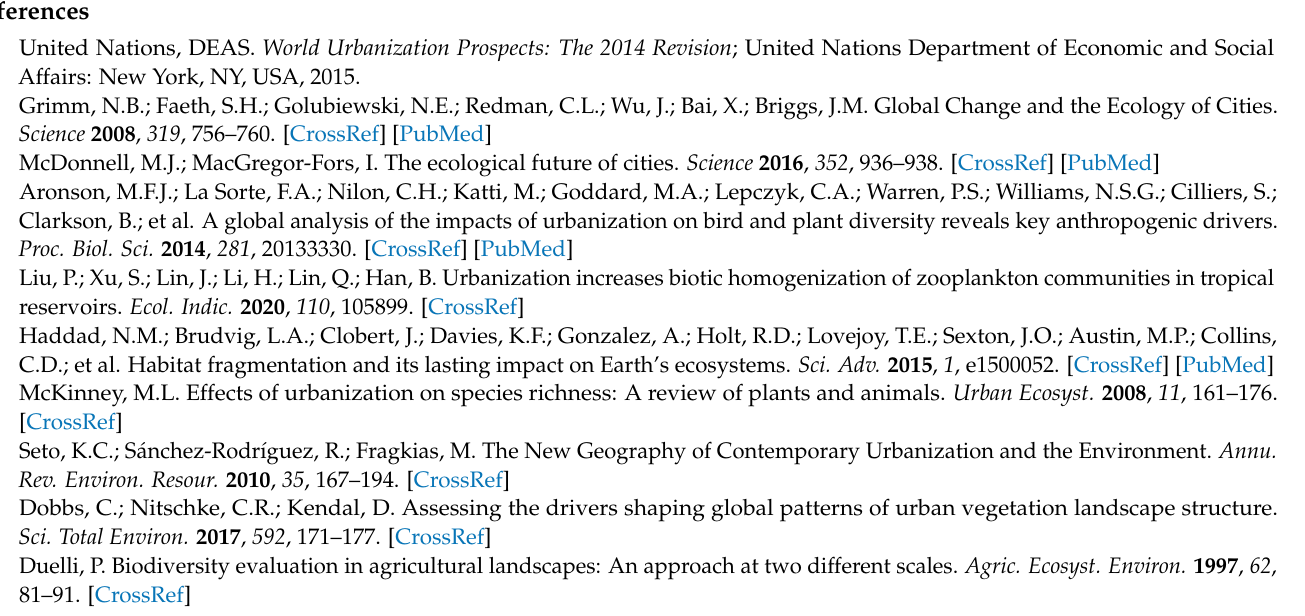
Correlation coefficient matrices for eight independent landscape variables at different spatial scales; Table S4: The best models ( ∆ i ≤ 2) examining relationships between multi-scale landscape variables and the relative abundances of five anuran species, total anuran relative abundance, and anuran species richness in 44 urban ponds in Shanghai. The best models predicting P. nigromaculatus are shown in Table S4a; the best models predicting F. multistriata are shown in Table S4b; the best models predicting M. fissipes are shown in Table S4c; the best models predicting B. gargarizans are shown in Table S4d; the best models predicting P. plancyi are shown in Table S4e; the best models predicting total anuran abundance are shown in Table S4f; the best models predicting anuran species richness are shown in Table S4g; Table S5: Model-averaged coefficients and 95% confidence intervals showing the direction relative magnitude of the effects of landscape variables on anuran relative abundance, and species at different spatial scales in urban landscapes in Shanghai. All possible models were estimated, using generalized linear modeling. Each coefficient was model-averaged across estimates from all models containing that coefficient. Bold font indicates p <